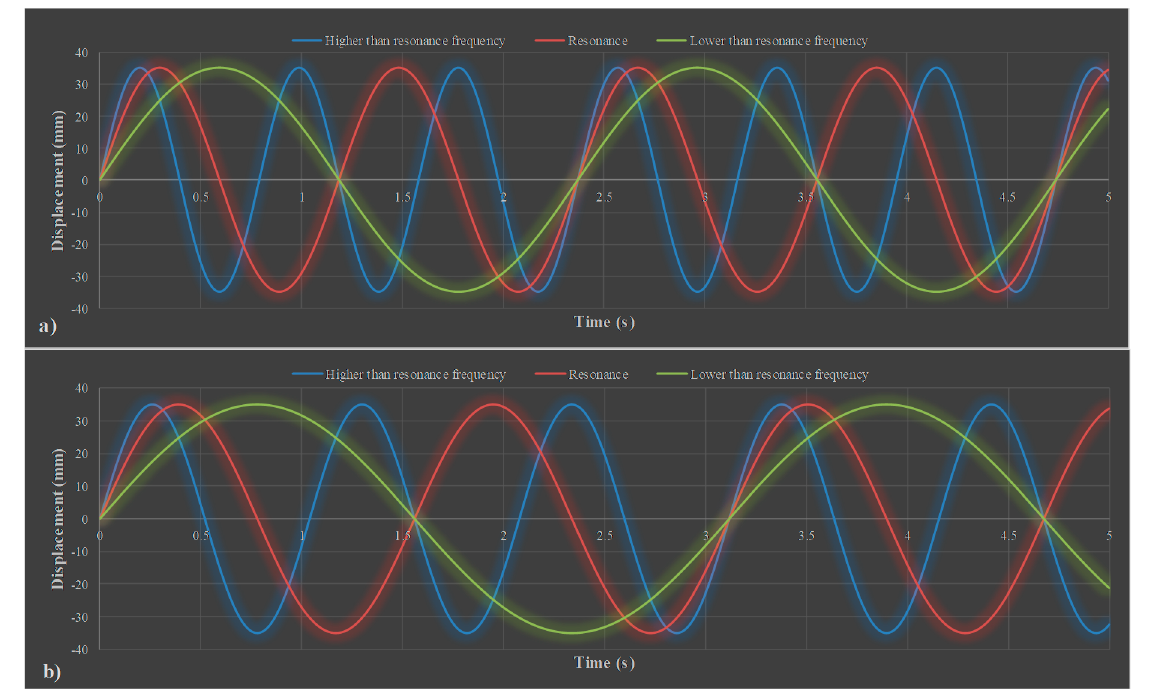
Figure 5. Displacement time-histories of the excitations applied at the base of the tank: ( a ) 100 mm liquid depth; ( b ) 200 mm liquid depth.